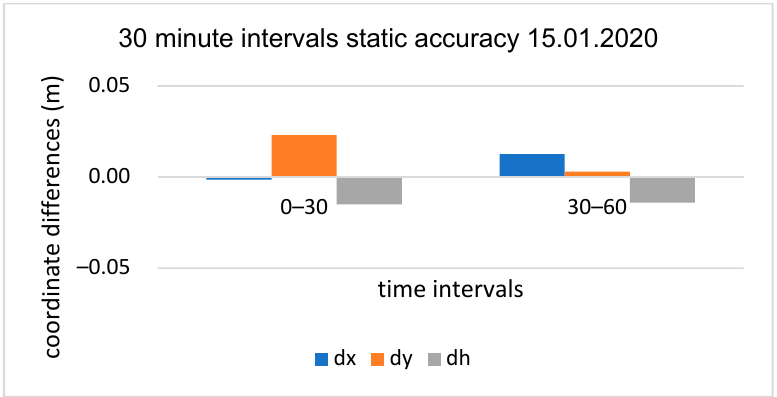
Figure 8. 20 min sub-session positioning results for initial test, baseline OPNT–P30Pro (4 km). Appl. Sci. 2020 , 10 , x FOR PEER REVIEW